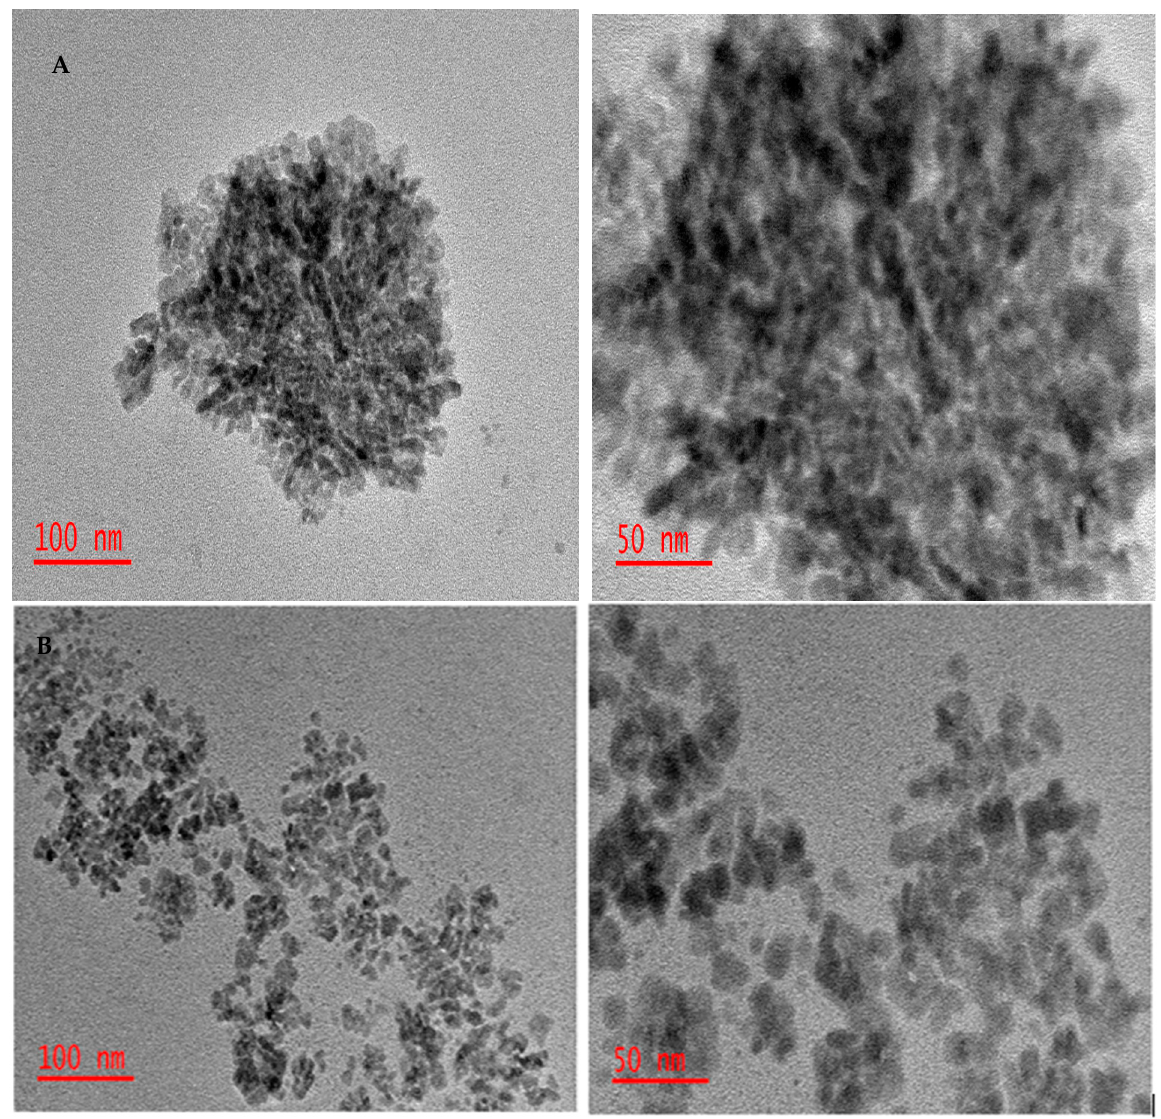
Figure 1. TEM images of the petrol soot nanoparticles before ( A ) and after oxidation ( B ). The successful oxidation of the soot particles was confirmed by the increased amount of oxygenated functional groups (including carboxylic and hydroxyl) observed from the FTIR spectra (Figure 2) [14,19]. Specifically, the appearance of bands at 1722 cm − 1 , 1545 cm − 1 , and 1384 cm − 1 representing C=O, C–C, and C–O stretch vibrations, respectively, are indicative of carboxylic group. The band observed at 1384 cm − 1 signifies the emergence of oxygenated moieties either from hydroxyl, carboxyl, or carbonyl as a result of the oxygenation [14], whilst the broad band at 3433 cm − 1 is as a result of O–H stretch, further confirming the presence of carboxylic acid groups.